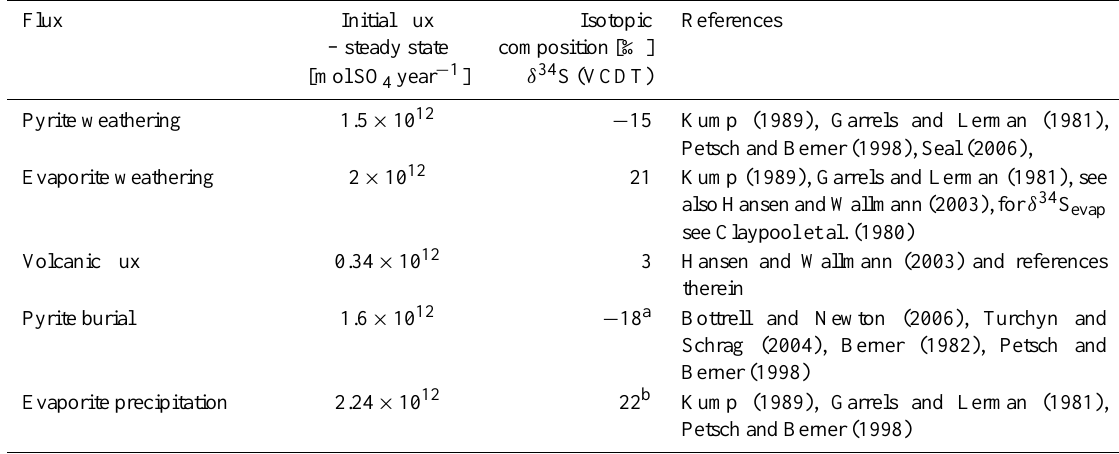
Table 1. Model fluxes and sulfur isotope ratios in the steady